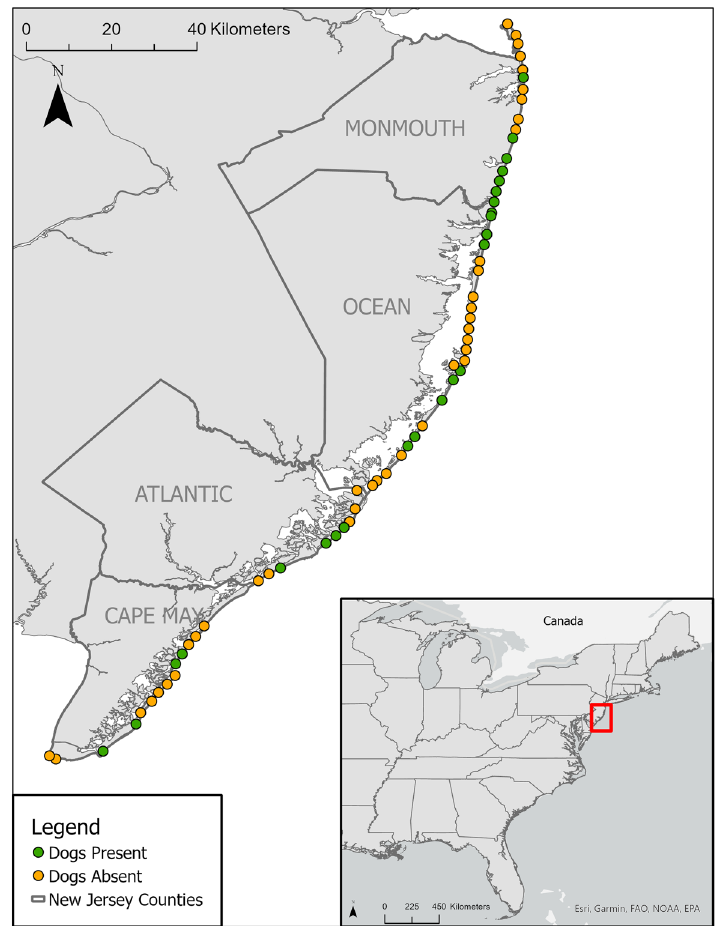
Figure 2. Camera deployment locations along ~ 250 km of the ocean-exposed coastline of New Jersey, USA. Green circles indicate camera locations where dogs were observed on cameras, and orange circles indicate camera locations where dogs were